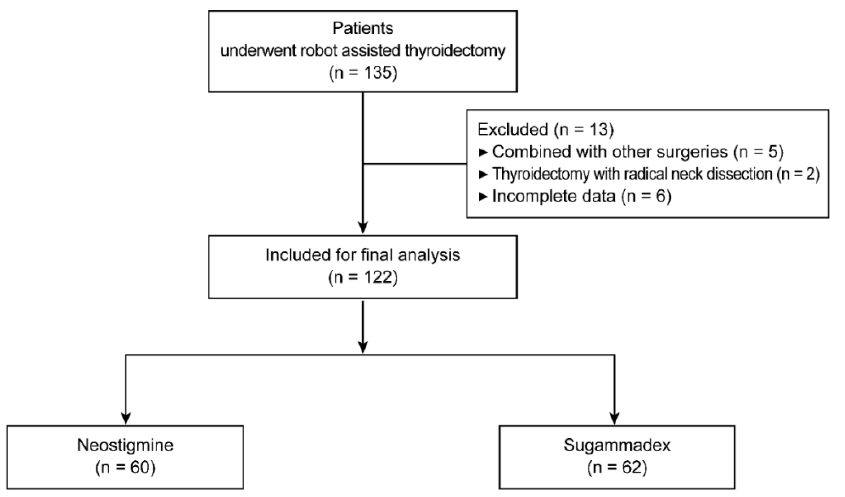
Figure 1. Flow diagram of patient selection.